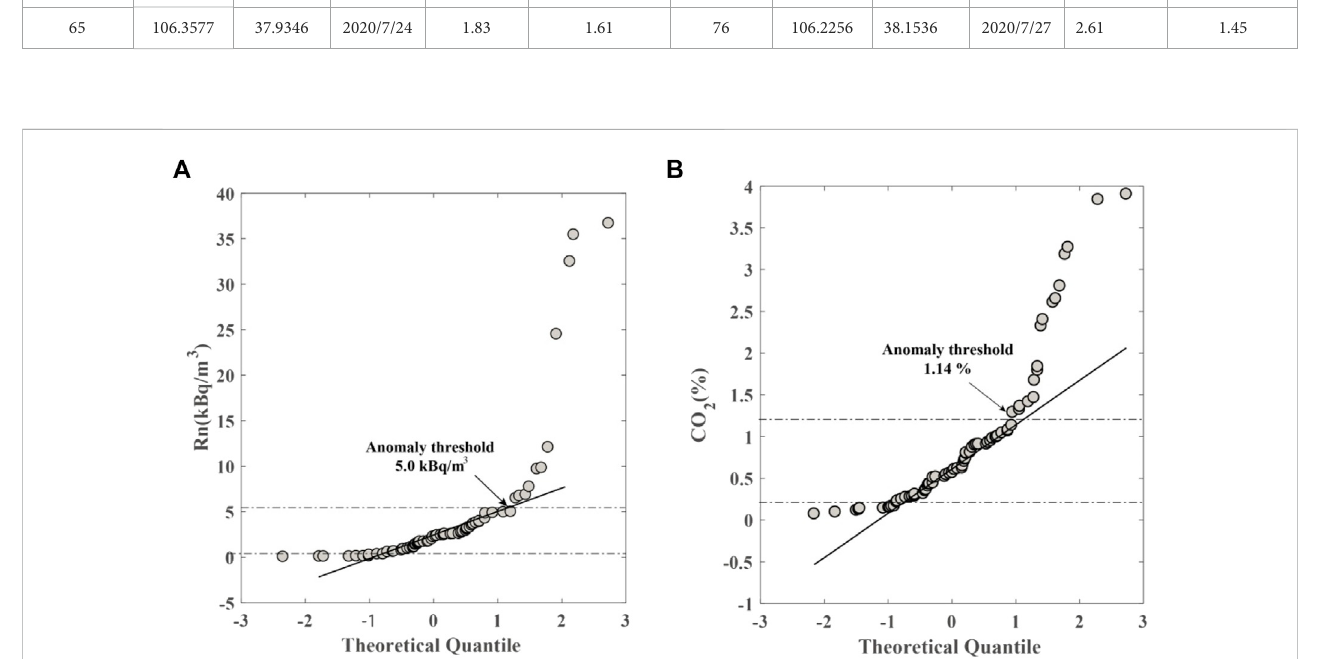
FIGURE 2 Anomaly thresholds of soil gas (A) Rn and (B) CO 2 estimated by the Q – Q plot method.